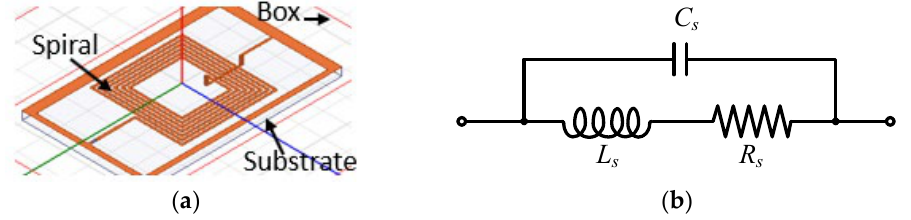
Figure 2. The spiral inductor topology: ( a ) designed in HFSS, and ( b ) the two-port lumped-element model.